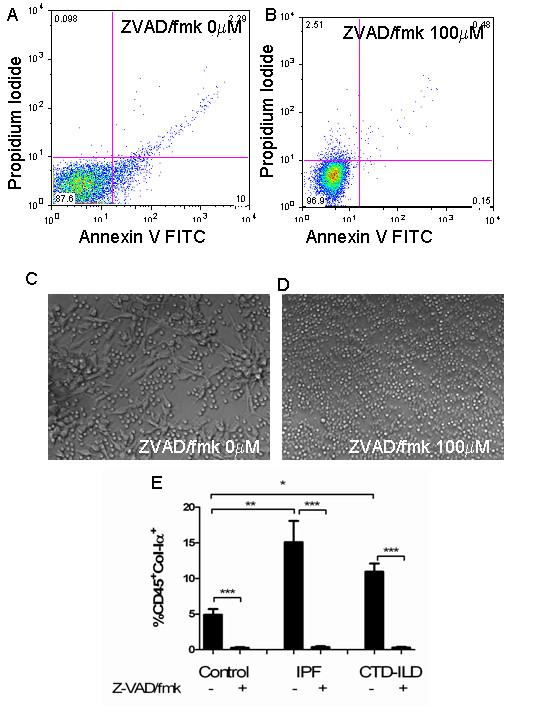
Caspase inhibition administration attenuates apoptosis and collagen production in cultured human monocytes. (a,b) Flow cytometric quantification of apoptosis based on annexin V (x axis) and propidium iodide (y axis) in cultured idiopathic pulmonary fibrosis (IPF) monocytes reveals that annexin V+ cells are reduced in the setting of Z-VAD/fmk. (c,d) Assessment of cultured connective tissue disease interstitial lung disease (CTD-ILD) monocytes indicates that, compared to mock-treated cells, cultured monocytes fail to adopt a spindle-shaped phenotype when treated with Z/VAD-fmk. Similar results are seen in patients with IPF (data not shown) (e) Treatment with Z-VAD/fmk attenuates collagen production in samples from all groups. *P < 0.05, **P < 0.01, ***P < 0.001.